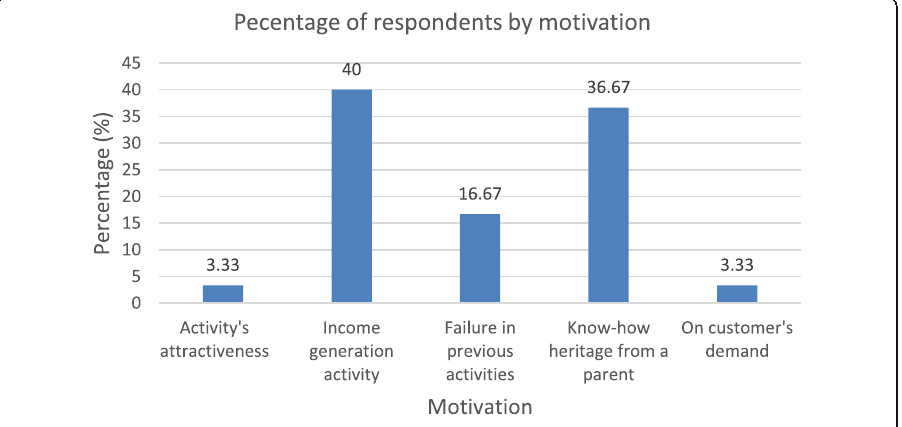
Fig. 2 Motivation for “ atta ” production handicraft. Source: Survey results, November to December